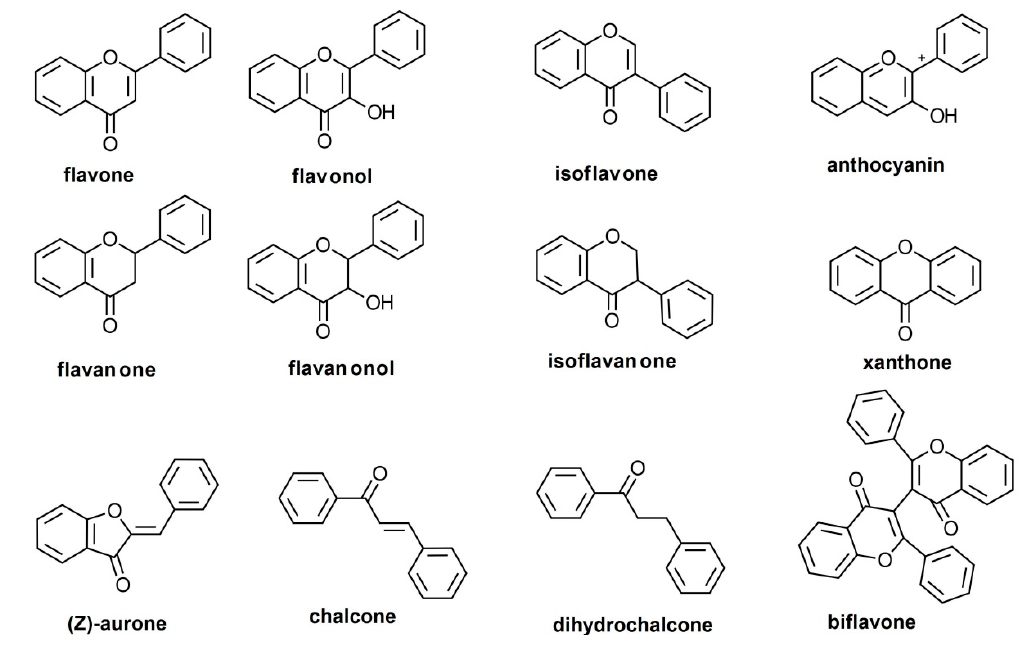
Figure 1. Basic chemical structures of different classes of flavonoids.